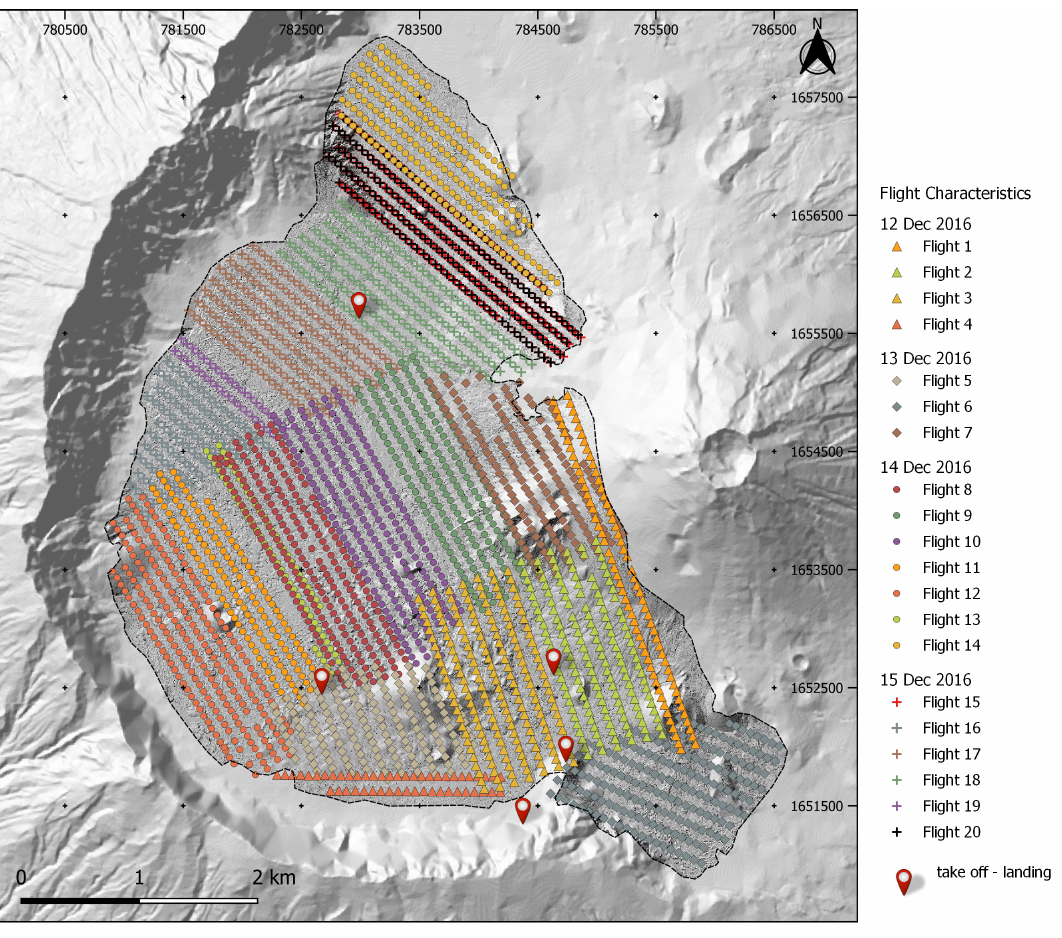
Figure 3. General characteristics of the aerial survey of the Chã das Caldeiras with the geolocation of the photographs according to the flights and take-off and landing locations. Shaded inside the survey area from the DSM produced here. Shaded relief outside the survey area from the DEMFI (2010) 5m